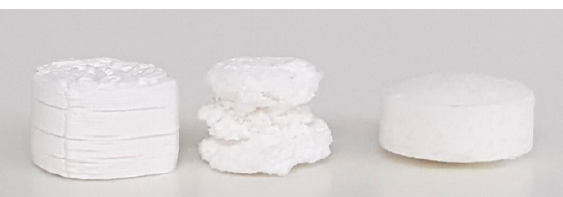
Figure 2. F1 tablets after dissolution test. From left to right: printed, HME and PM tablets. The three types of tablets had the same cylindrical geometry with the same SA/V (0.8 mm − 1 ) before dissolution. However, the residual after dissolution (shown in this figure) showed that PM and printed tablets preserved their integrity while HME tablets showed erosion, which could be responsible for the increased release % of HME tablets compared to PM and printed ones, as shown in Figure